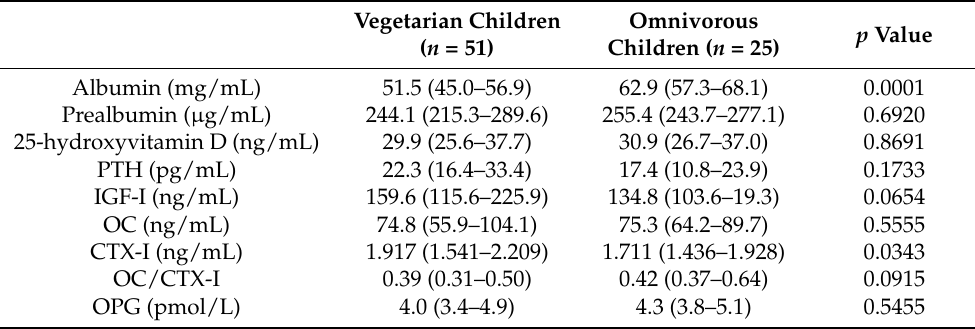
Table 4. Serum concentration of biochemical parameters (albumin, prealbumin, and bone metabolism markers) in children on vegetarian and omnivorous